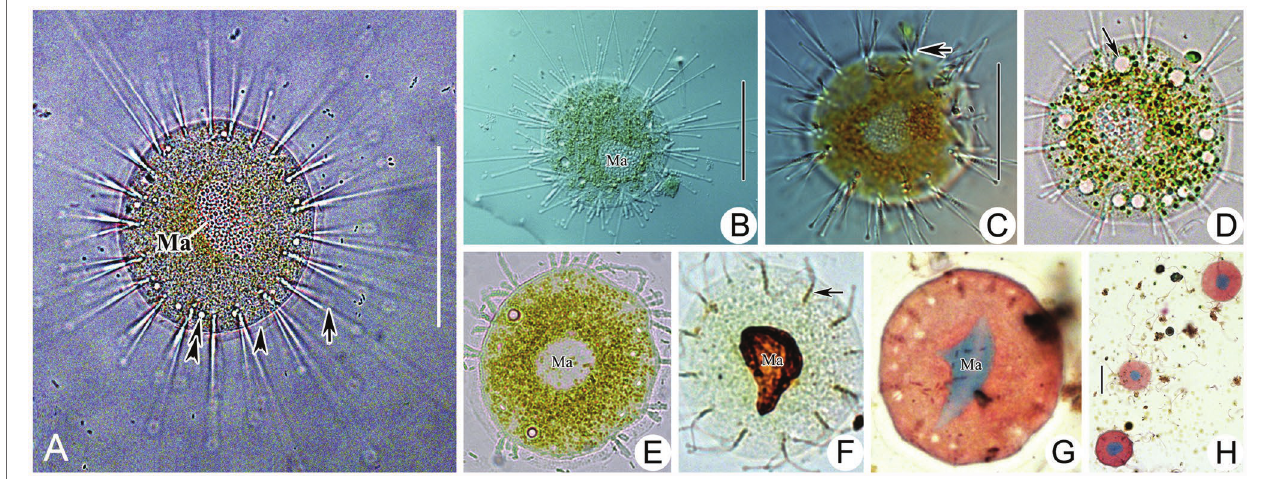
FIGURE 6 | Photomicrographs of Heliophrya rotunda (Hentschel, 1916) Matthes, 1954 from life (A–E) and after protargol staining (F) as well as Methyl Green-Pyronin Staining (G,H) . A. Heliophrya rotunda in vivo . Arrow to show tentacle. Arrowhead to show adhesive disc. Double arrowheads to show contractile vacuole. (B–E) To show different individuals. Arrow in (C) to indicate tentacles in rows. Arrow in (D) to indicate contractile vacuole. (F) Heliophrya rotunda after protargol staining. Arrow to show the tentacle arrangement, to indicate tentacles in rows. (G,H) Heliophrya rotunda after Methyl Green-Pyronin Staining. Ma, macronucleus. Scale bars = 50 μ